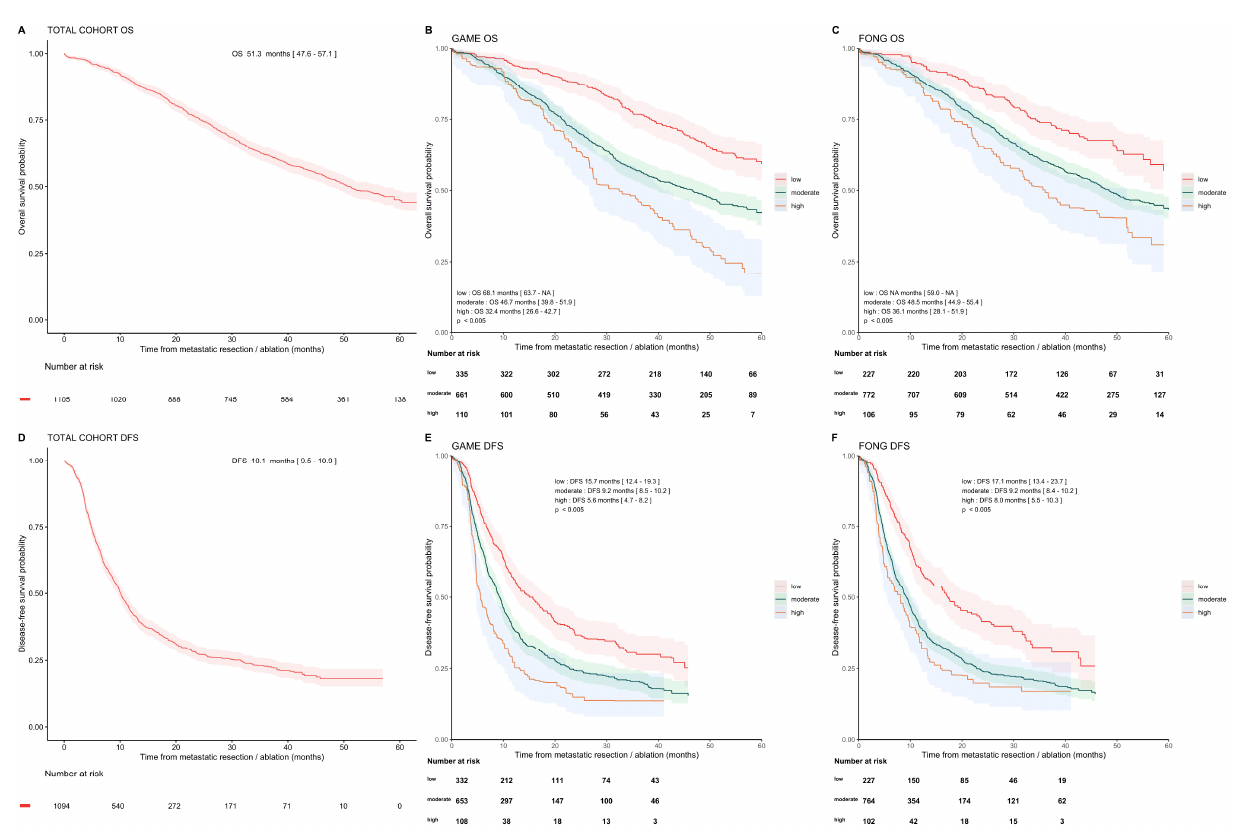
Table 2. Characteristics of original Fong and GAME CRS cohorts compared to Dutch NCR cohort used for external validation. GAME